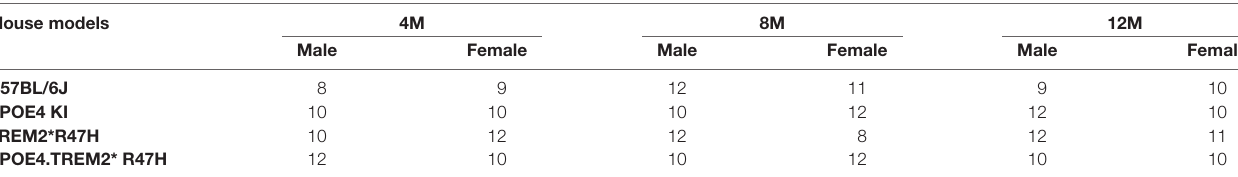
TABLE 3 | In vivo imaging study